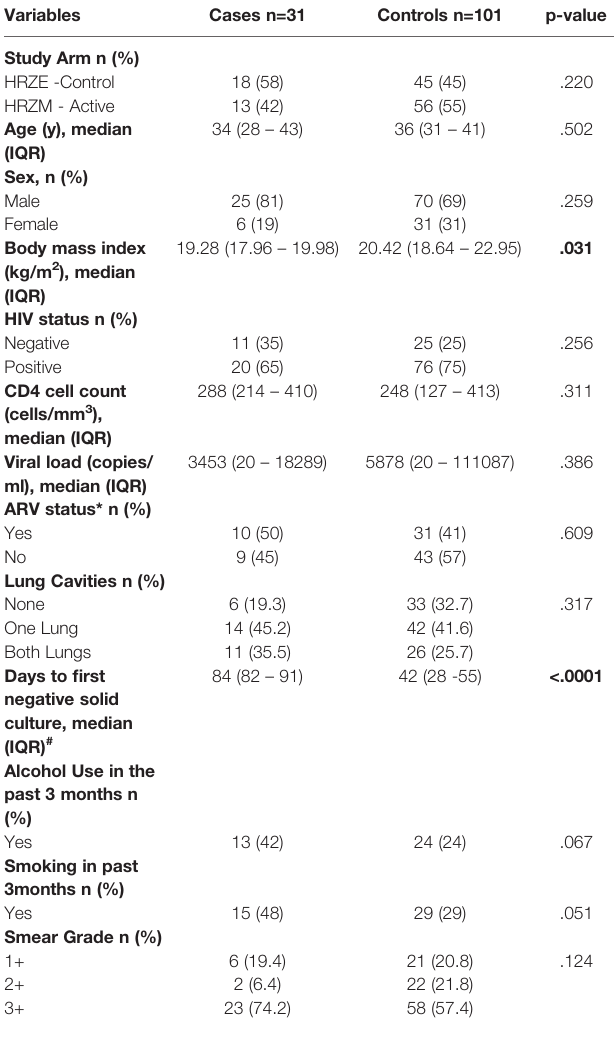
TABLE 1 | Demographic and clinical characteristics of study